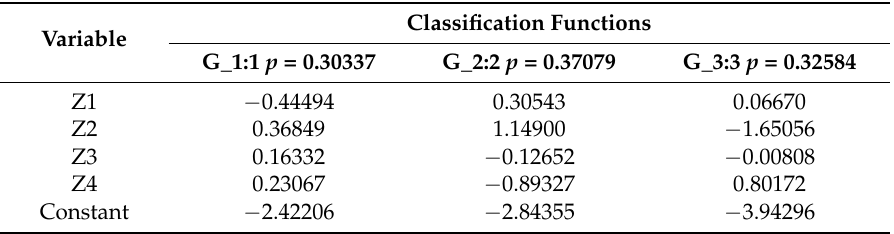
Table 8. Discriminant function coefficients for recycled MCAS mixes with waste